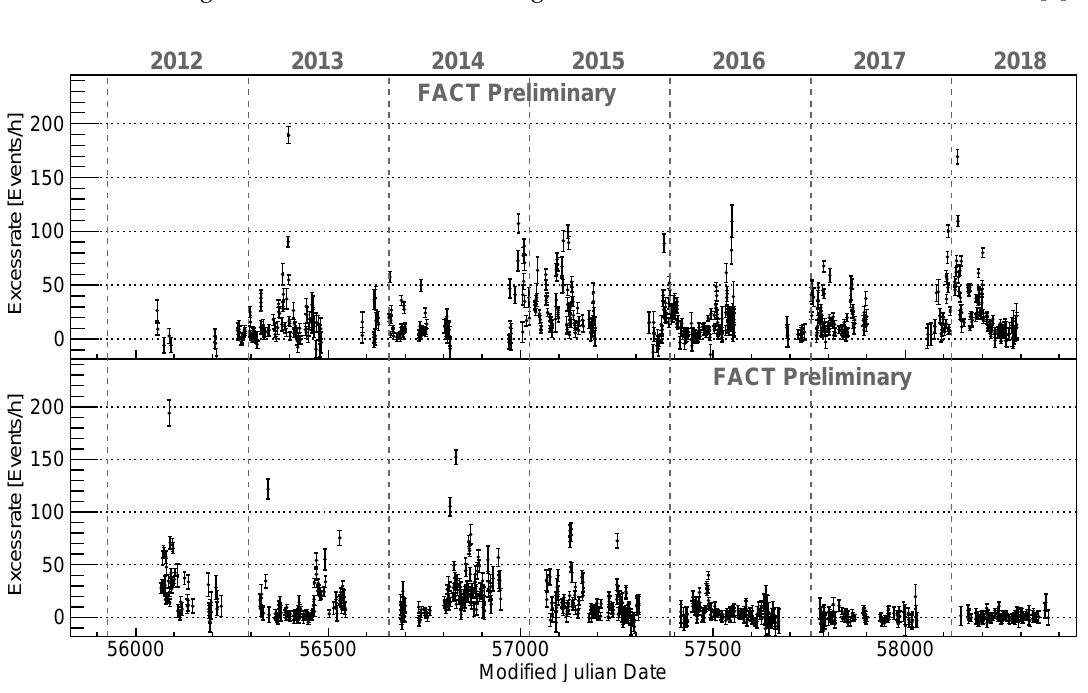
Figure 1. Light curves of Mrk421 (top) and Mrk501 (bottom) measured by the first G-APD Cherenkov telescope (FACT). The vertical gray dashed lines indicate the start of a